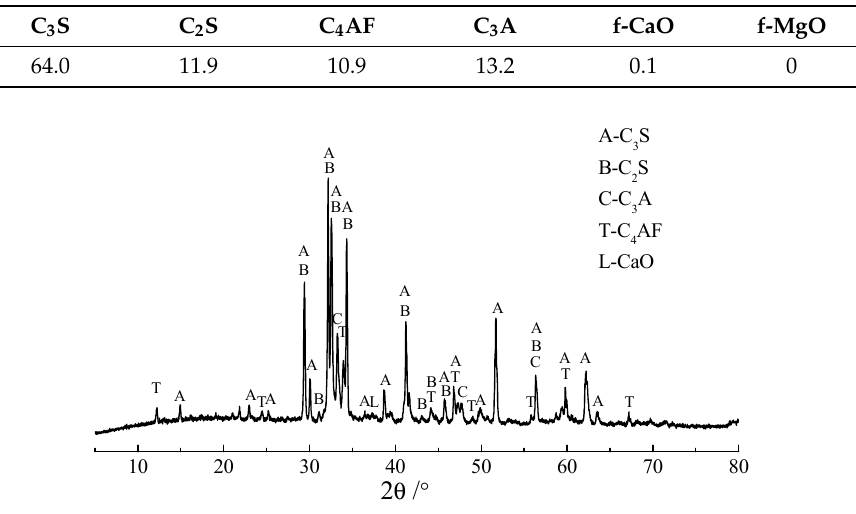
Figure 3. The XRD pattern of self-made cement clinker.